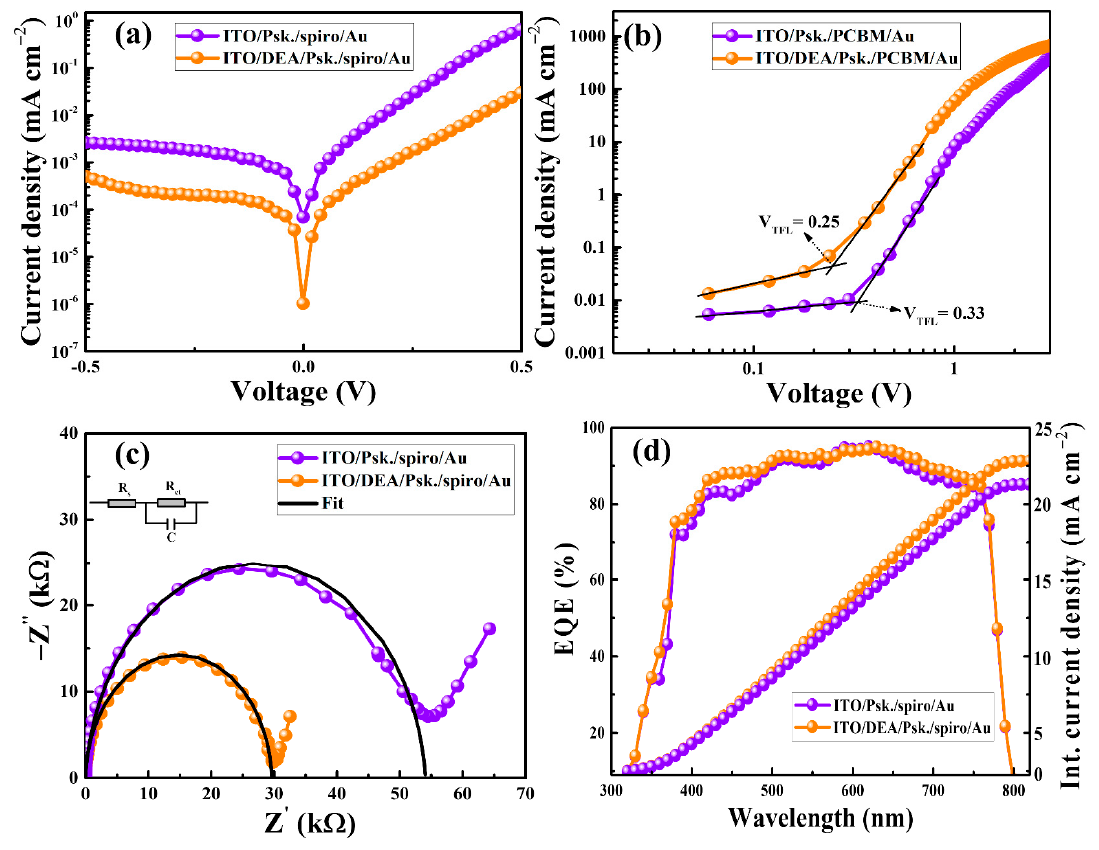
Figure 7. Dark J-V curves of as-prepared devices ( a ) and electron-only devices ( b ), EIS measurement ( c ), and EQEs with integrated J sc of the PSCs prepared using ITO substrates and ITO/DEA substrates ( d